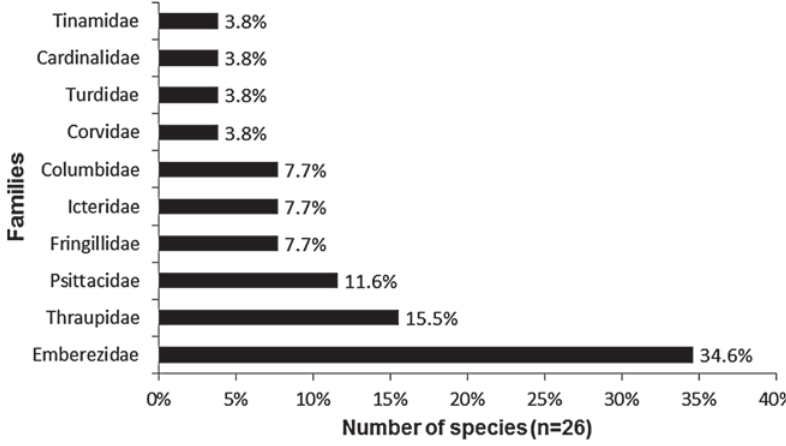
Figure 2 - Bird families encountered in the homes of bird